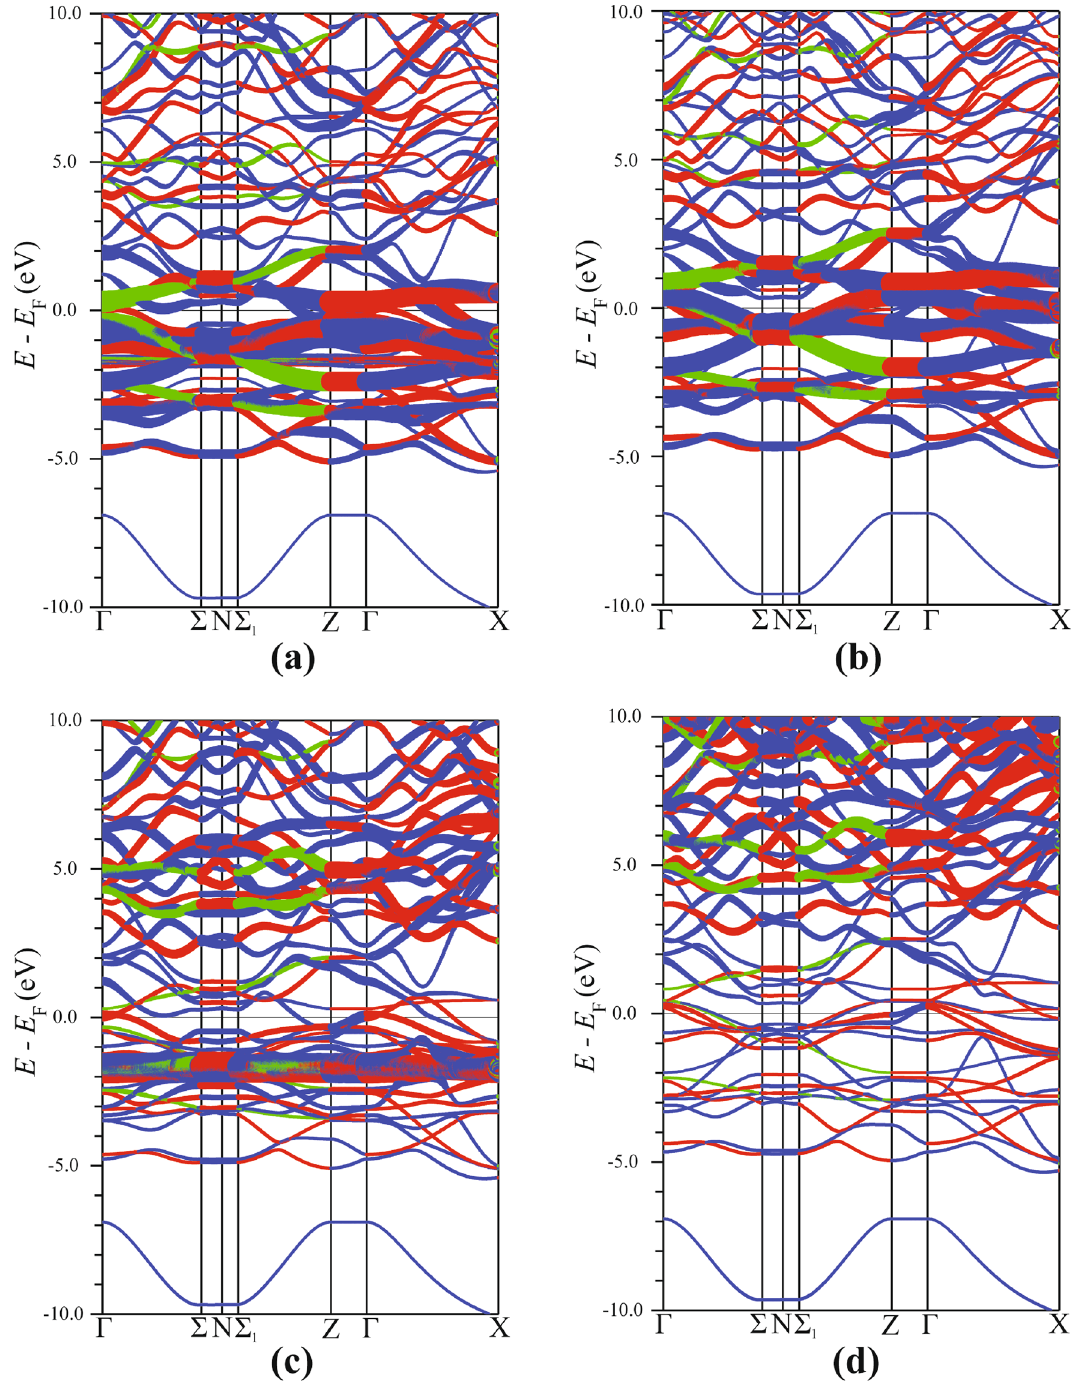
Figure 8. Spin-polarized, weighted energy band structure of EuFeAs 2 . The spin-up ( a ) and spin-down ( b ) band structure of Fe. The spin-up ( a ) and spin-down ( b ) band structure of Eu. SigmaPlot v14, www. systa tsoft ware.